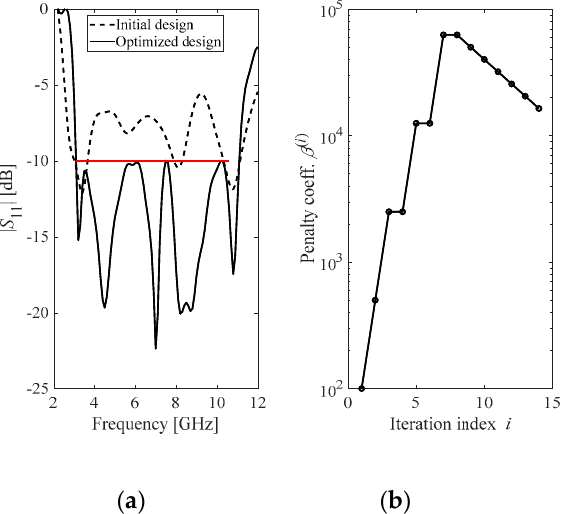
Figure 5. Antenna I: representative run of the proposed algorithm with automated adjustment of the penalty factors: ( a ) reflection coefficient at the initial (- - -) and optimized design ( — ); ( b ) evolution of the penalty coefficient throughout the algorithm iterations.